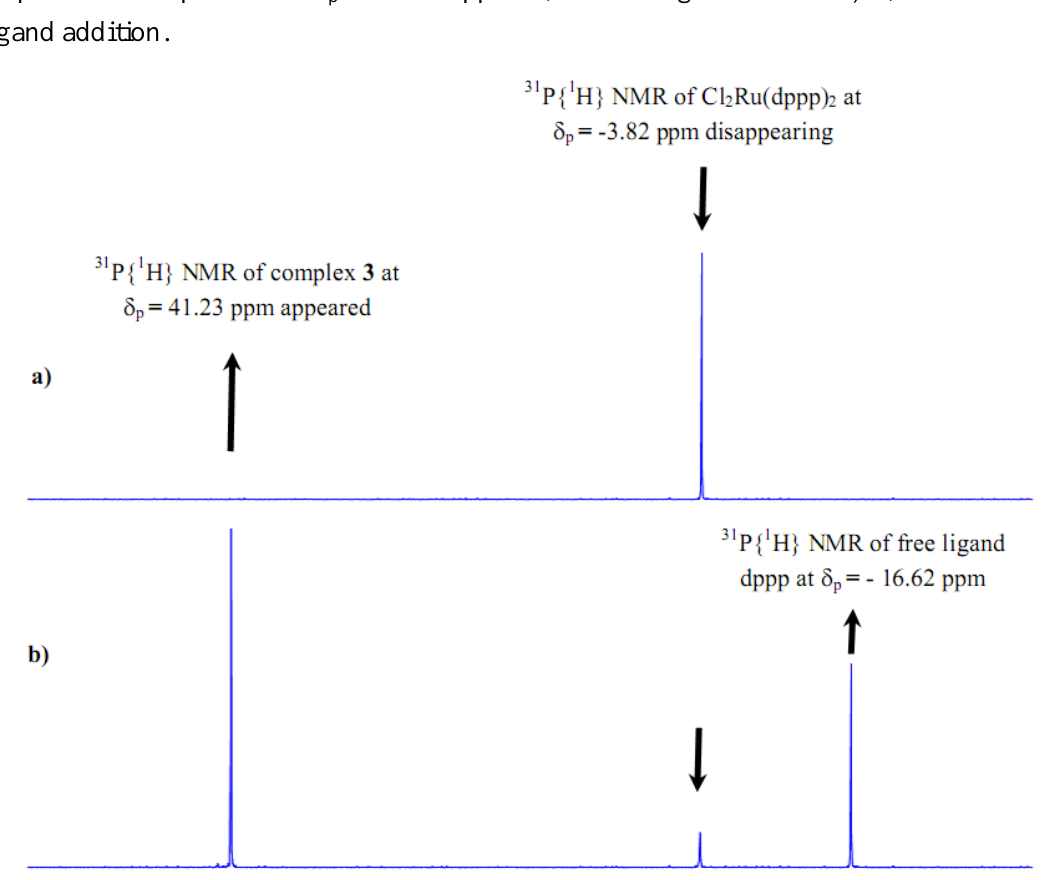
= 41.23 ppm a) before ligand addition, b) 20 min. after p